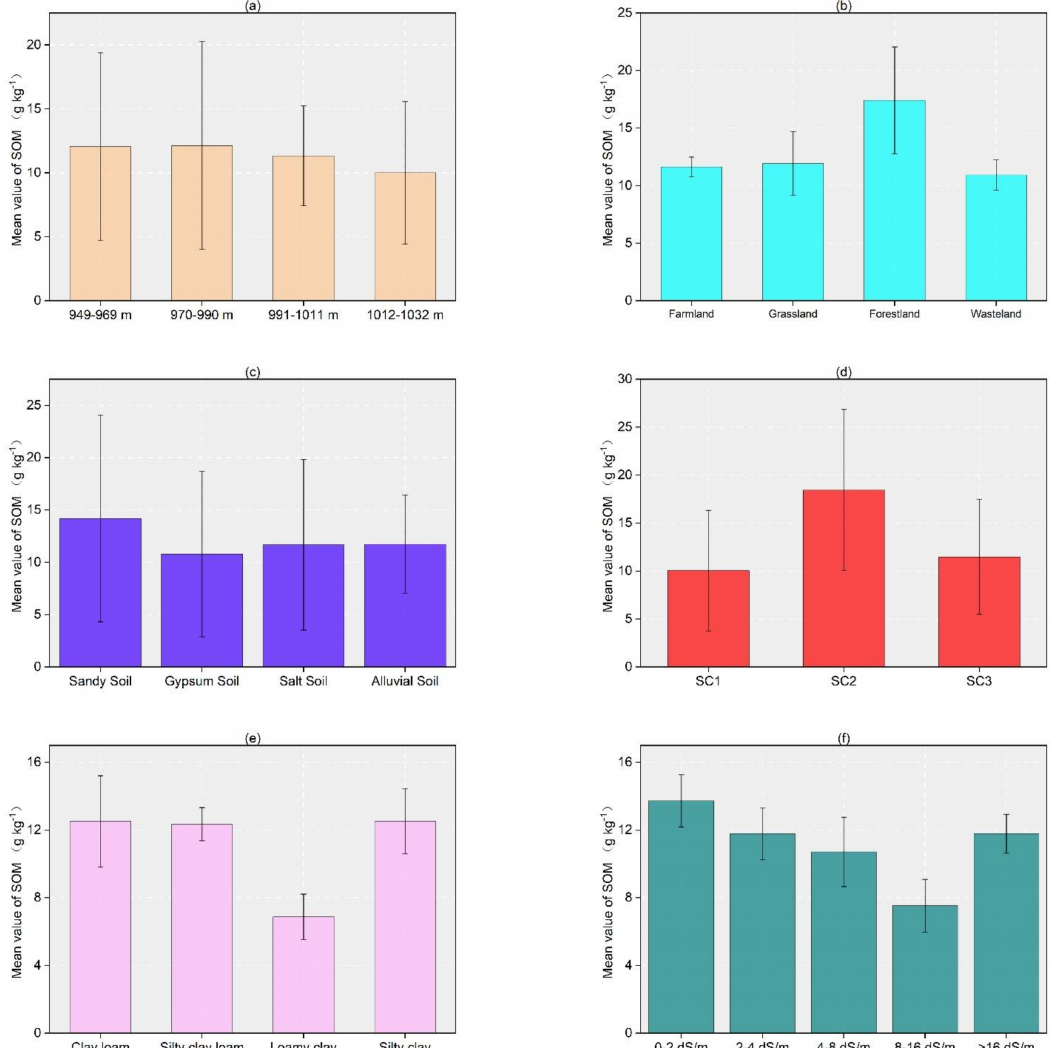
Figure 4. Mean SOM contents for each auxiliary variable and their standard errors; ( a ) DEM, ( b ) LULC, ( c ) soil texture, ( d ) spectral classification, ( e ) WRB, and ( f ) salinity (black lines represent standard